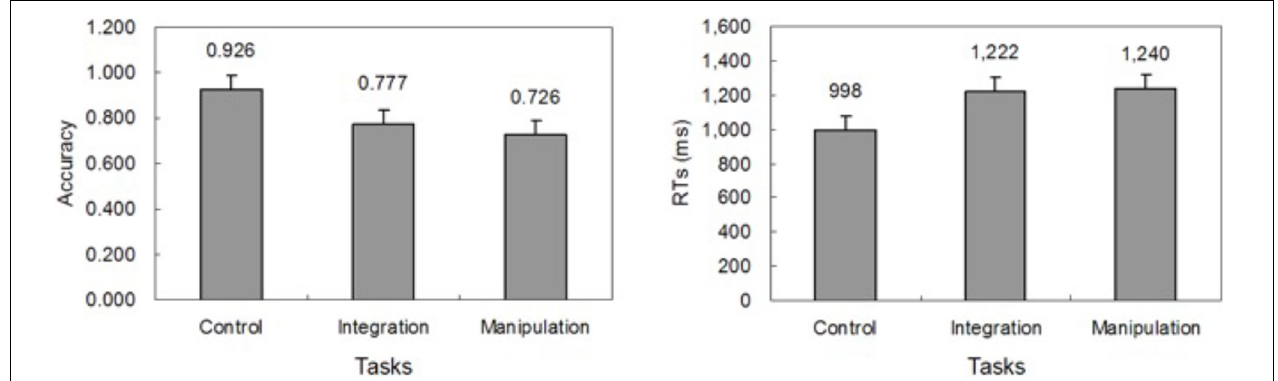
FIGURE 2 | Behavioral results. Mean accuracy (left) and response time (right) across subjects for the control, integrate, and manipulate conditions.